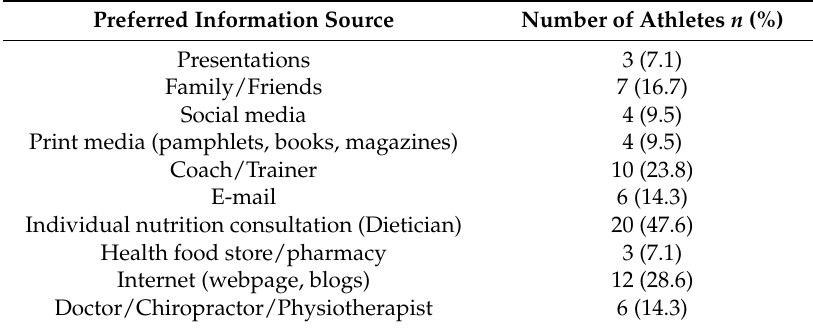
Table 5. Preferred Information Sources for Dietary